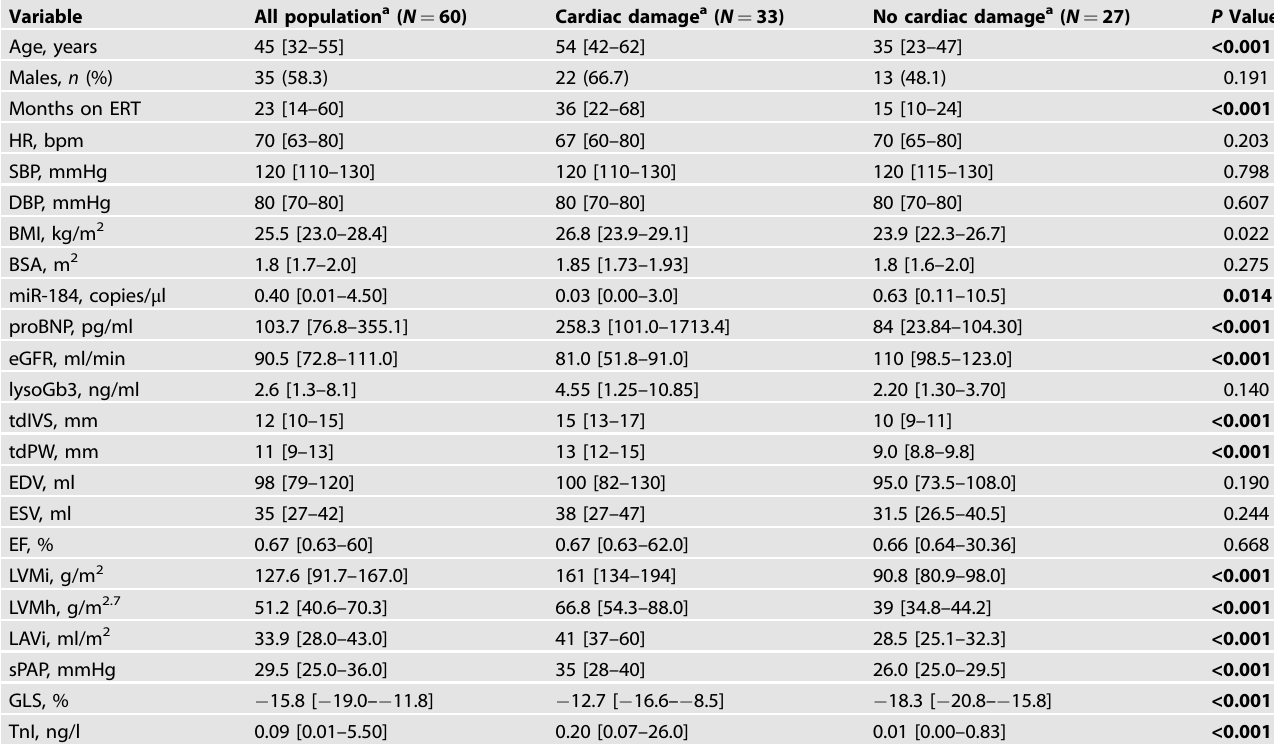
Table 2. Clinical characteristics of 60 AFD patients under chronic ERT strati fi ed for the presence of cardiac damage.